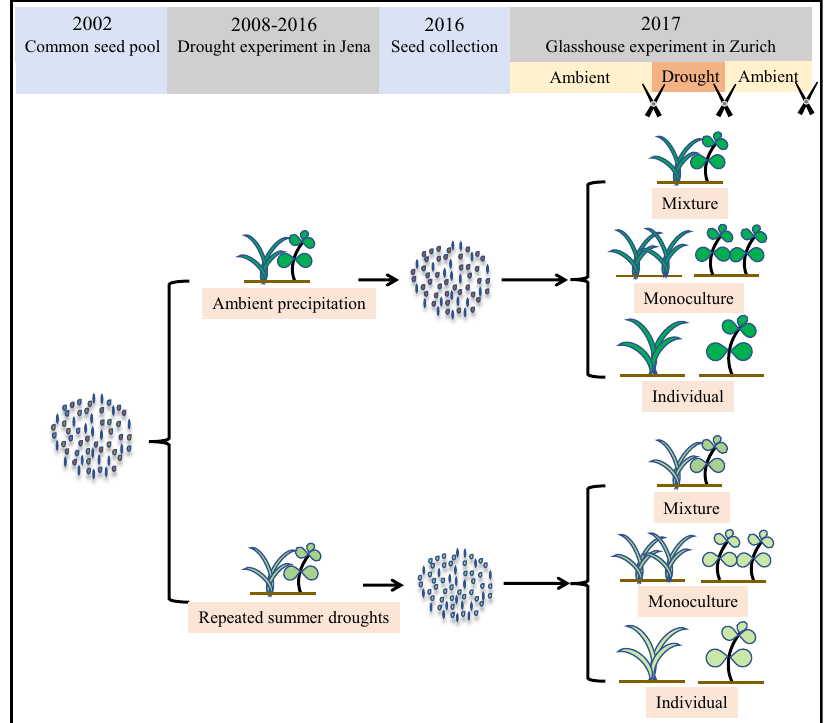
Fig. 1 Experimental design. Seeds collected from different selection treatments (8-years treatments of recurrent summer droughts vs. ambient control) in the Jena Experiment, Germany, were sown in 2-species mixtures, in monocultures, or individually in pots in a glasshouse at the University of Zurich, Switzerland. During a fi rst phase of 3 months, pots were watered regularly (ambient conditions, “ before drought ” ). This was followed by a second phase of 2 weeks without watering (drought conditions, “ during drought ” ). Finally, a third phase of 7 weeks with regular watering allowed the plants to recover and regrow after the experimental drought (ambient conditions for recovery, “ after drought ” ). Plants were harvested after 14 – 16 weeks (before the drought), 20 weeks (at the end of the drought), and 27 weeks (after recovery from the drought) as represented by scissors. After the fi rst harvest, plants were watered regularly and allowed to regrow before the drought